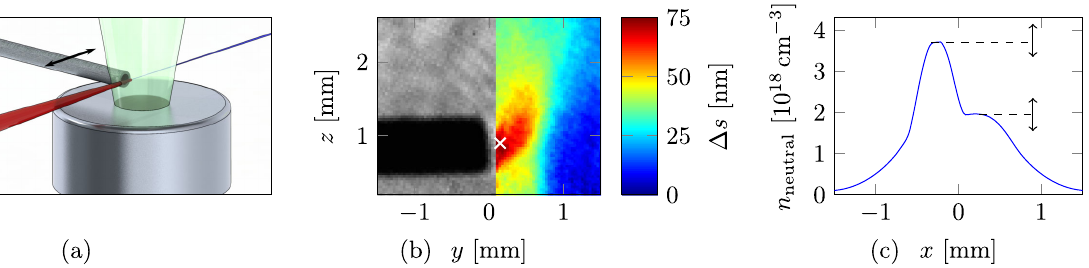
FIG. 1. A schematic illustration of the experimental setup is shown in (a). The laser pulses (red) are focused on the front edge of the gas jet provided from a 2 mm nozzle with its orifice located 1 mm from the optical axis. A narrow tube is inserted into the jet, with its orifice 0.2 mm from the optical axis, and provides locally an additional amount of gas. The electrons (blue) accelerated in the interaction propagate along the optical axis. Measurements, using a wavefront sensor, of the additional optical path length introduced by the gas in an optical probe beam allows the neutral gas density profile to be determined. In (b) the additional path length ( Δ s ) introduced by the gas, supplied from both nozzles simultaneously, is shown in the color scale in the part not obstructed by the narrow tube. The 2 mm nozzle is located just below the edge of the image and supplies a flow of gas along the vertical ( z ) axis. The shadow of the narrow tube marks its position in the left part of the figure. The optical axis of the main laser beam is perpendicular to the plane of the figure and its position in the plane is marked as a white cross. The typical neutral gas density ( n ) distribution along the optical ( x ) axis used in this neutral experiment is shown in (c). The tube can be moved along the optical axis to change the position of the density peak and thus also the density down-ramp. Furthermore, the density in the peak and plateau can be varied